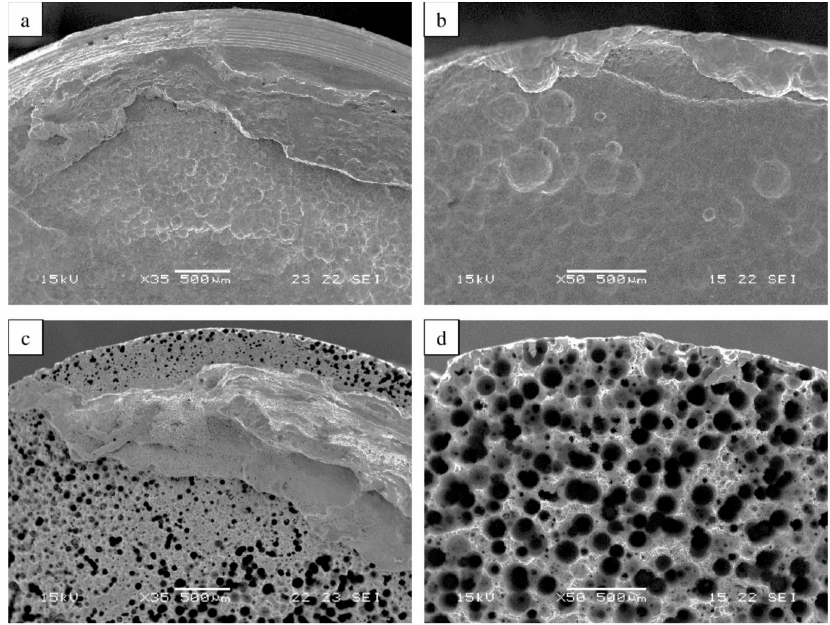
Figure 10. Close-up views of corrosion attack at the surface of the printed ER70S-6 alloy and reference ST-37 alloy after salt spray testing in 3.5% NaCl solution. ( a , b ) printed alloy after exposure times of 30 days and 45 days, respectively; ( c , d ) reference alloy after exposure times of 30 days and 45 days,